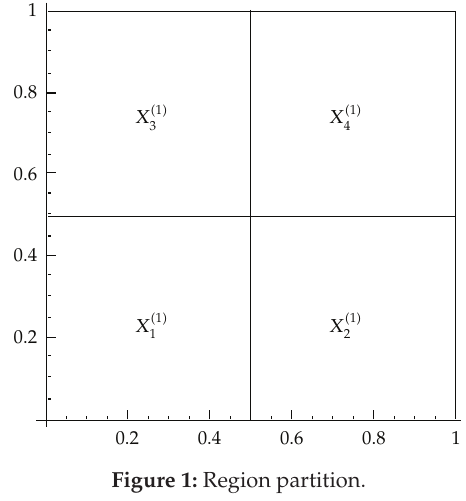
Figure 1: Region